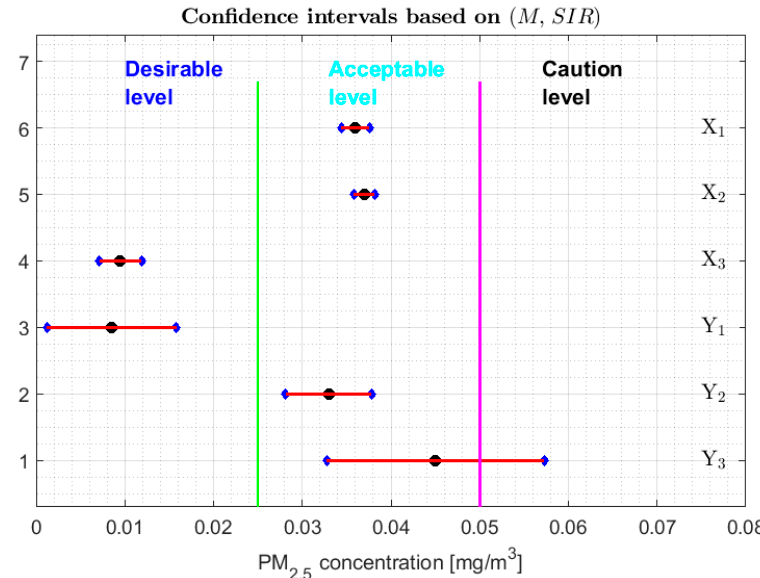
Figure 8. 95% confidence intervals based on (M,SIR) , and the bands that delimit the three lowest categories of air pollution by PM 2.5 concentrations in Quito. Median: Black circle; Ends of the intervals: Blue diamonds.